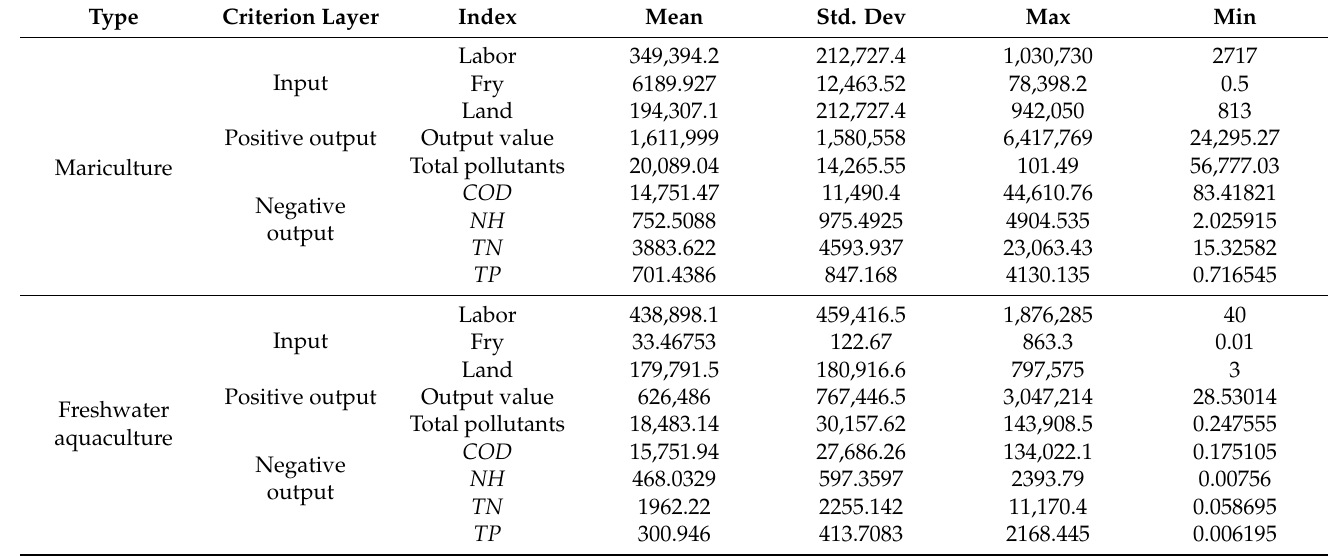
Table 2. Descriptive statistics of input and output